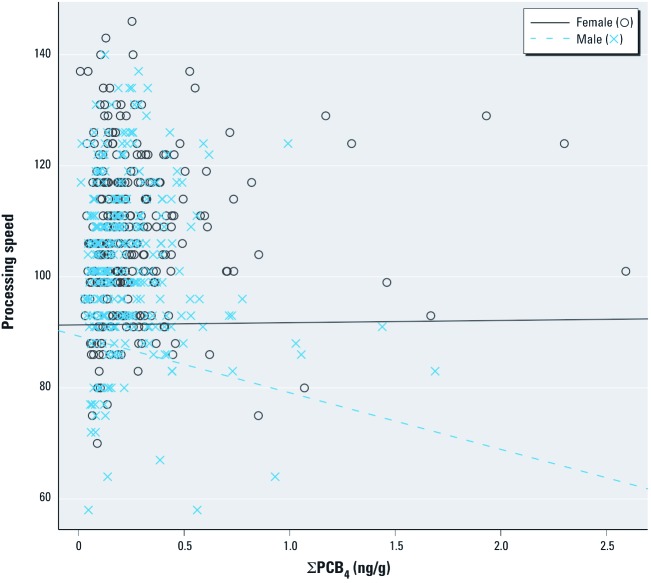
Unadjusted scatterplots and adjusted linear regression lines of the association between cord serum levels of ΣPCB4 and processing speed on the WISC-III by sex for 8-year-old children born in New Bedford, 1993–1998, adjusted for child’s age at examination and sex, maternal age at birth and prenatal smoking, and maternal intelligence and maternal education. Adjusted β-values: females, 0.0 (95% CI: –1.0, 1.1); males, –2.0 (95% CI: –3.5, –0.4).